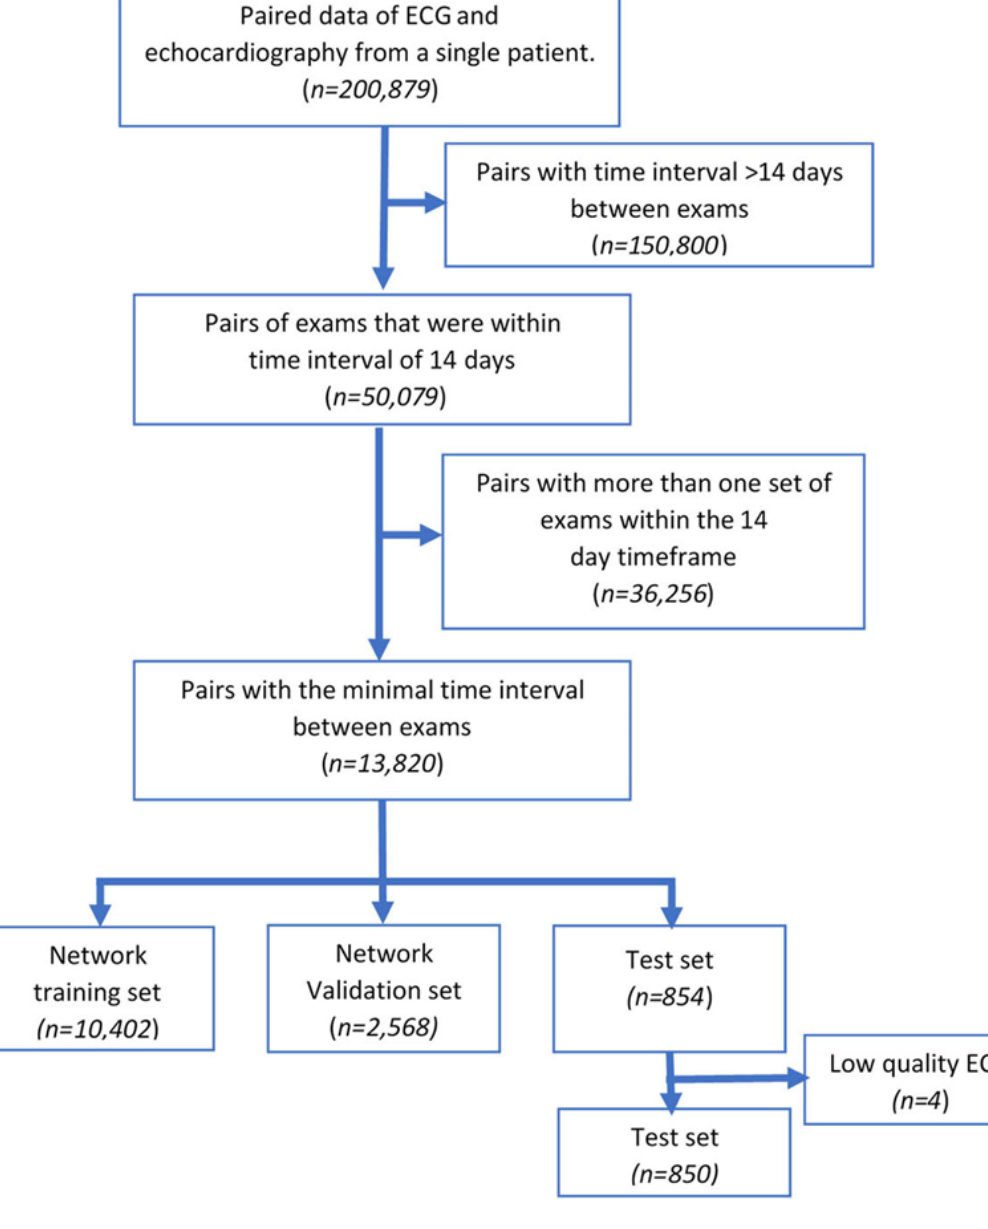
Figure 1. Study flow diagram. As demonstrated in Table 2, compared with patients with normal EF, patients with LVSD were more likely to be males with a higher incidence of cardiovascular risk factors including, among others, diabetes mellitus, hypertension, and